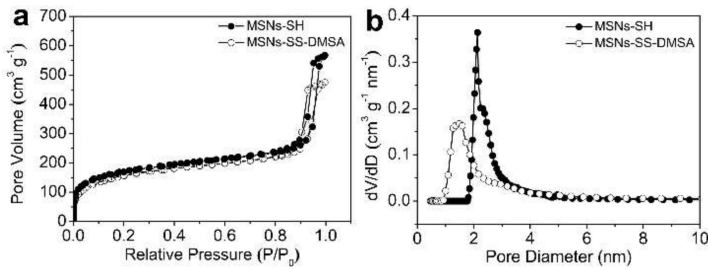
Figure 1. SEM ( a ) and TEM ( b ) images of MSNs-SH.